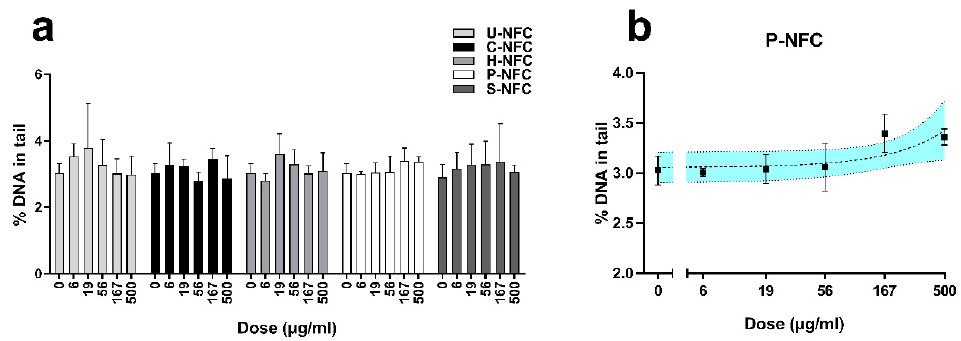
Figure 6. Induction of DNA damage by the nanofibrillated cellulose (NFC) materials. DNA strand breaks were assessed at 24 h exposure to ( a ) U-NFC, C-NFC, H-NFC, P-NFC, and S-NFC. A significant linear dose response ( p = 0.0427) was induced by P-NFC ( b ). Data are expressed as percentage of DNA in tail and presented as the mean ± standard error of the mean. Significant linear dose-response is plotted with 95% confidence interval (colored area).